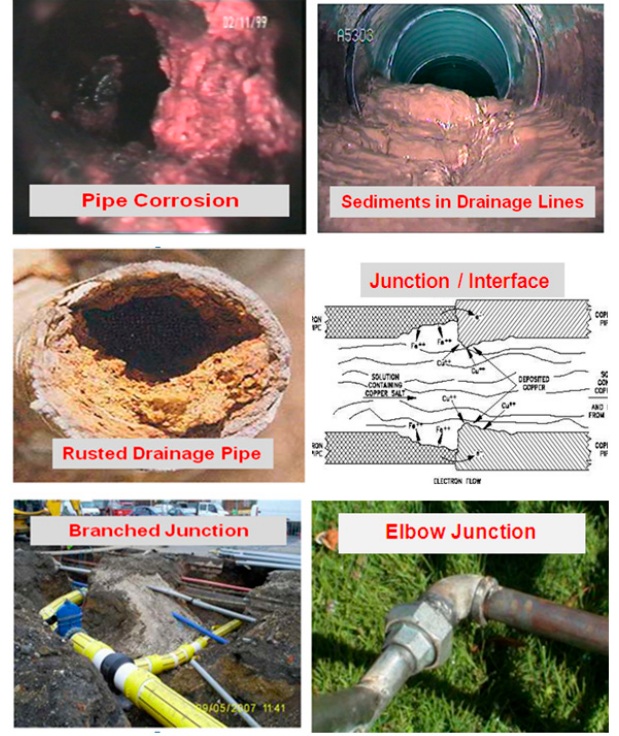
Figure 3. Different factors attributed to non-uniformities of pipe diameter (pictures adapted from online public sources on google websites).